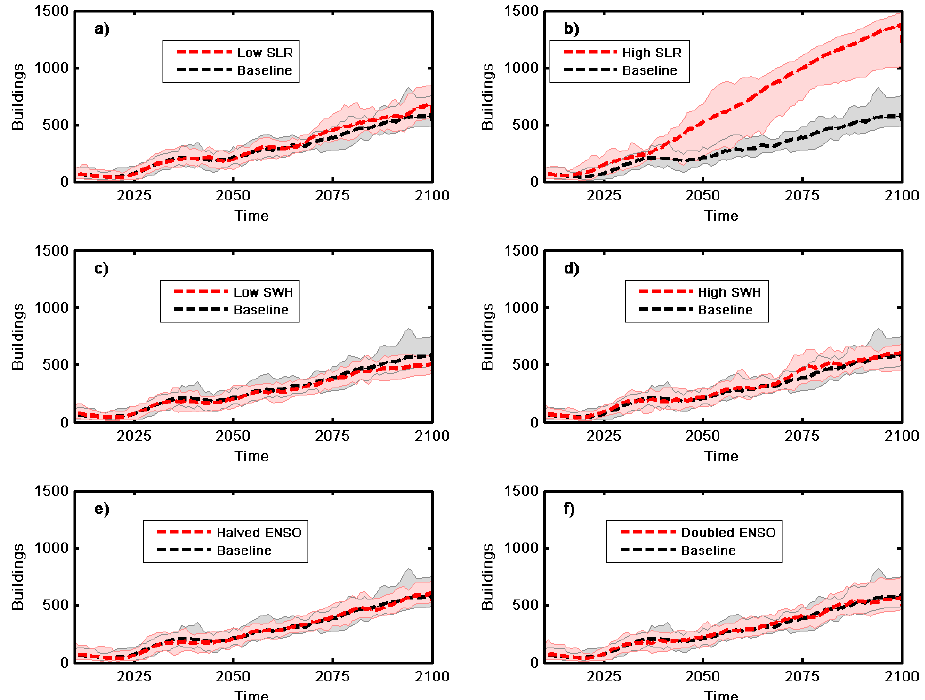
Figure 4. Number of buildings impacted by flooding through time under each of the six climate drivers (panels a – f ) compared to the baseline. Dashed lines indicate the decadal mean of all simulations. Bounds represent the minimum and maximum decadal means.